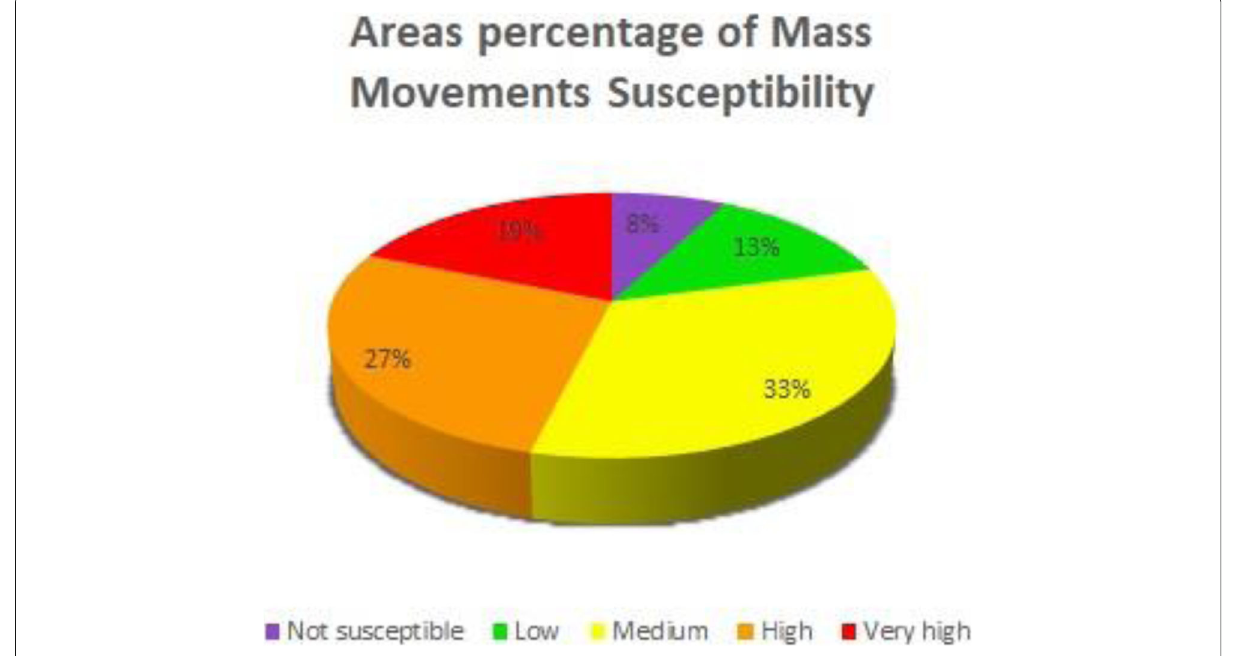
Fig. 10 Percentage of susceptible areas